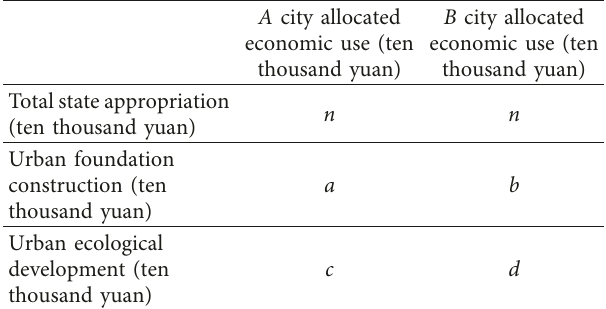
Table 2: The amount use and allocation of urban infrastructure construction and ecological planning between the two